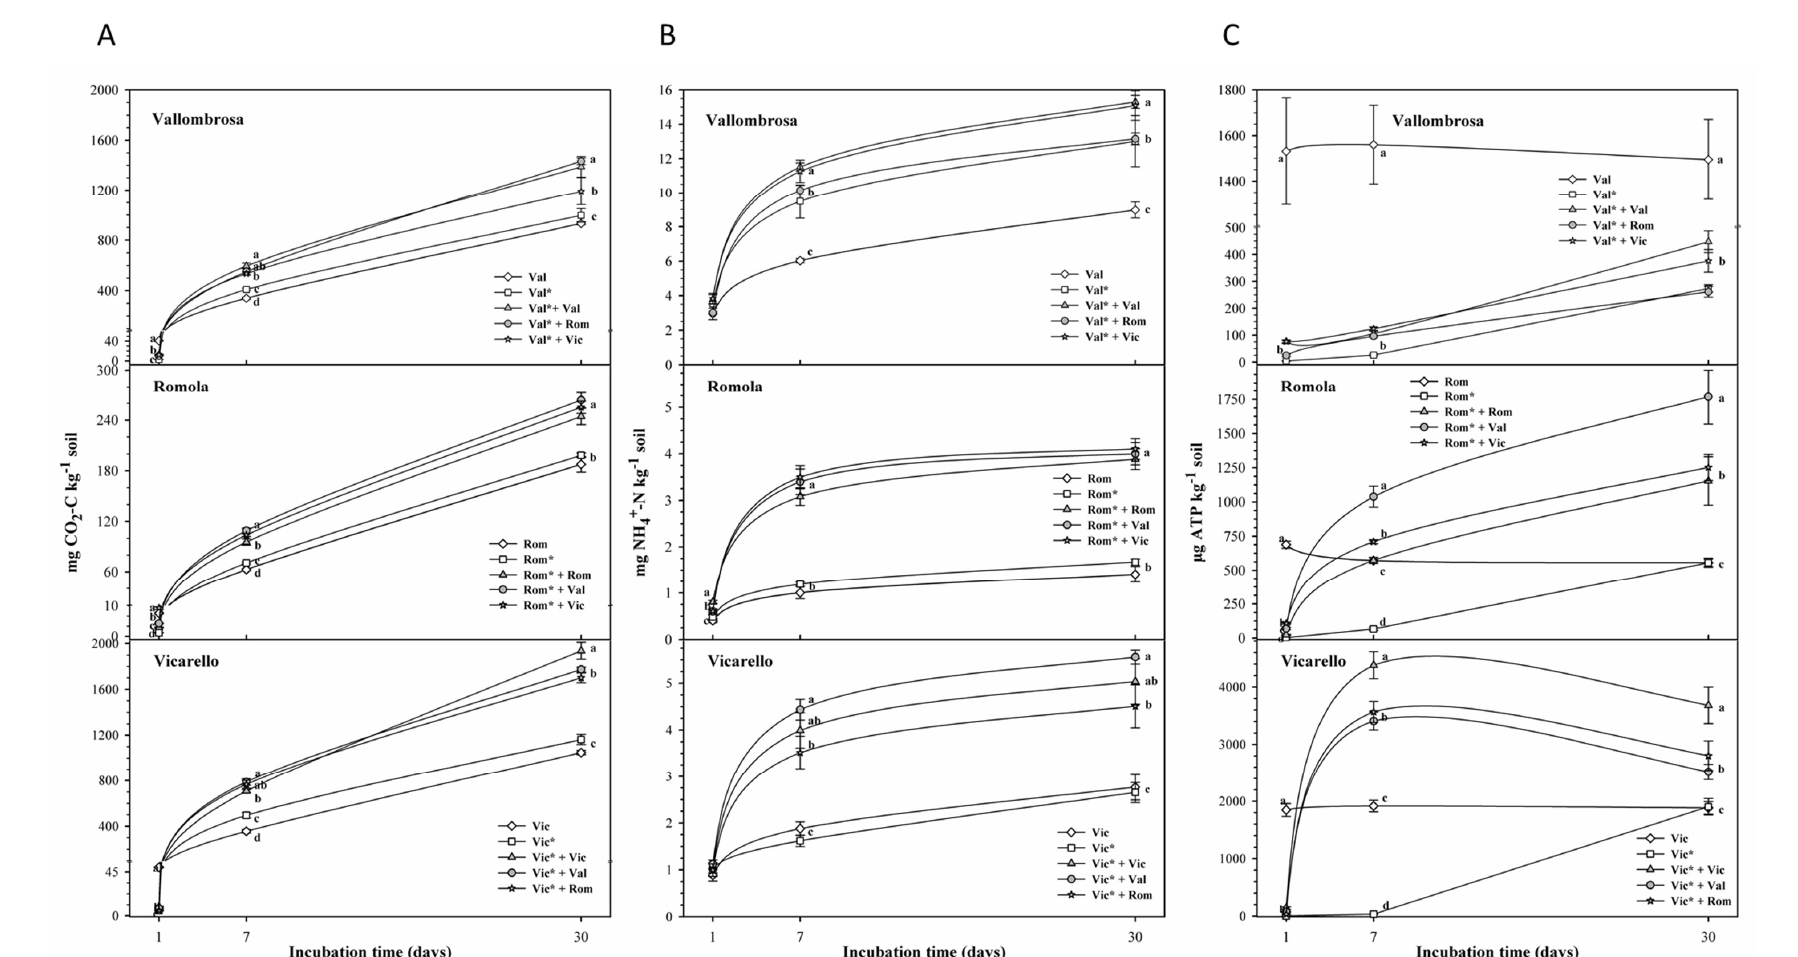
Figure 1. ( A ) Cumulative soil respiration in reinoculated soils during a 30 d incubation experiment. ( B ) Ammonification in self- or cross-reinoculated soils during a 30 d incubation experiment. At each sampling time, different letters indicate a significant ( p < 0.05) difference among means (n = 3). ( C ) ATP content in reinoculated soils during a 30 d incubation experiment. Heat-sterlized and non-inoculated soils (Val*, Rom*, Vic*) together with non-heat-sterilized and non-reinoculated soils (Val, Rom, Vic) were taken as control treatments. At each sampling time, different letters indicate a significant ( p < 0.05) difference among means (n = 3).